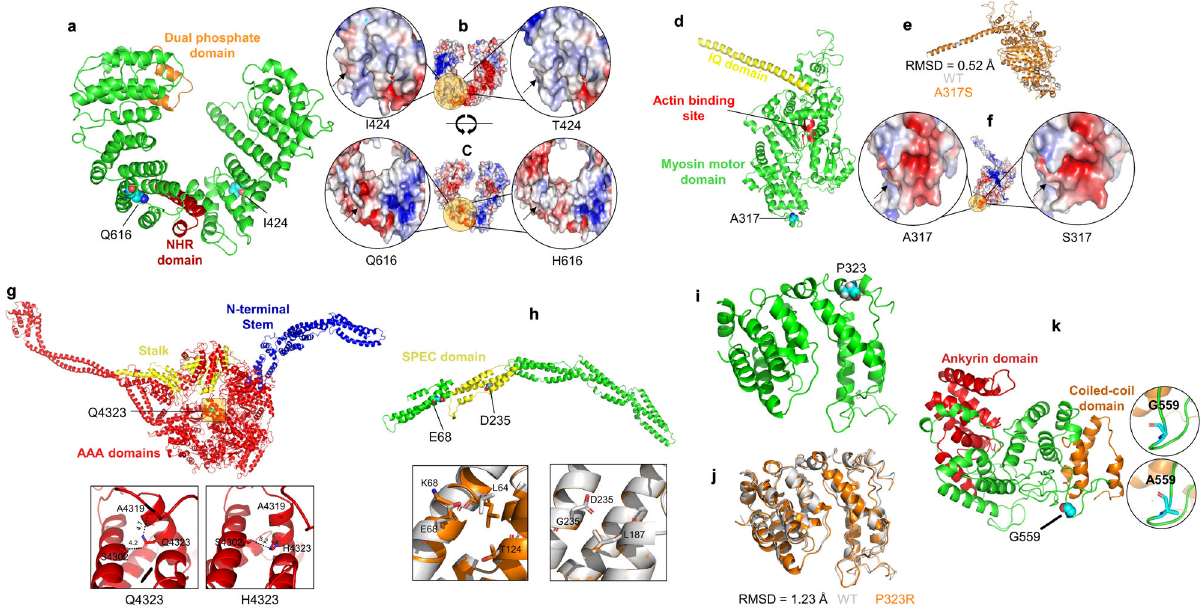
Fig. 5 Structural modeling missense variants in novel hearing impairment candidate genes. a Homology model of INPP4B. The mutated residues (I424T and Q616H) are represented with a sphere model. The NHR and dual phosphate domains are indicated with red and orange colors, respectively. b , c The electrostatic potential surface of wild-type and mutant protein is highlighted in the circle zoom-up view showing different patches (indicated by the arrow) around the mutated residue. d Three-dimensional structure of MYO19 showing the mutated residue, A317, in a sphere model. The actin-binding pocket, myosin motor, and IQ domain are represented by green, red, and yellow colors, respectively. e The superposed structure of the WT (gray) and mutant (orange) structure of MYO19 shows the root-mean-square deviation. f The electrostatic potential surface of wild-type and mutant protein is highlighted in a circle zoom-up view showing different patches (indicated by the arrow) around the mutated residue. g Three-dimensional structure of DNAH11 showing the N-terminal stem (blue), stalk (yellow), and the mutated residue Q4323 (sphere model) of the AAA domain (red). The difference in the interaction network due to the mutation is highlighted in the bottom panel. The residue is represented with a stick model and the distance between the residues is labeled in angstrom. h Predicted structure of CCDC141 showing the mutated residues in a sphere model. The bottom row represents the zoom-up view of WT (gray) and mutant type structures displaying the different orientations of residues (stick model). i Three-dimensional structure of PAX8. j The superposed structure of WT (gray) and mutant (orange) structure showing the difference in overall conformation due to the P323R mutation. k Predicted structure of POTEI showing the wild-type and mutated residues in a stick model in the right